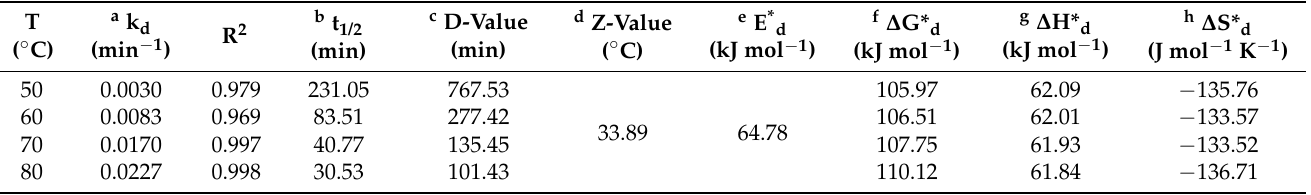
Table 6. Kinetic and thermodynamic parameters of thermal denaturation of crude Aspergillus tamarii URM4634 protease produced by sequential fermentation using wheat bran as a